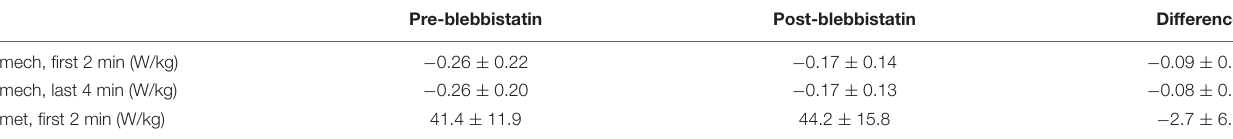
FIGURE 8 | Typical example of work loop shape and work per cycle as a function of cycle number for a concentric trial with movement amplitude 0.25 mm and 2 Hz movement frequency, pre-blebbistatin. (A) Bundle force against length, for cycle numbers 1, 10, 50, 100, 150, and 240 (top to bottom curves). (B) Net mechanical work per cycle as a function of cycle number. Ticks on the x -axis correspond with lines in panel (A) (the tick at cycle number 1 was left out for readability). The data in this figure corresponds to the data in Figure 3 . TABLE 6 | Mean ± SD average mechanical and metabolic power during the passive work loops. Pre-blebbistatin